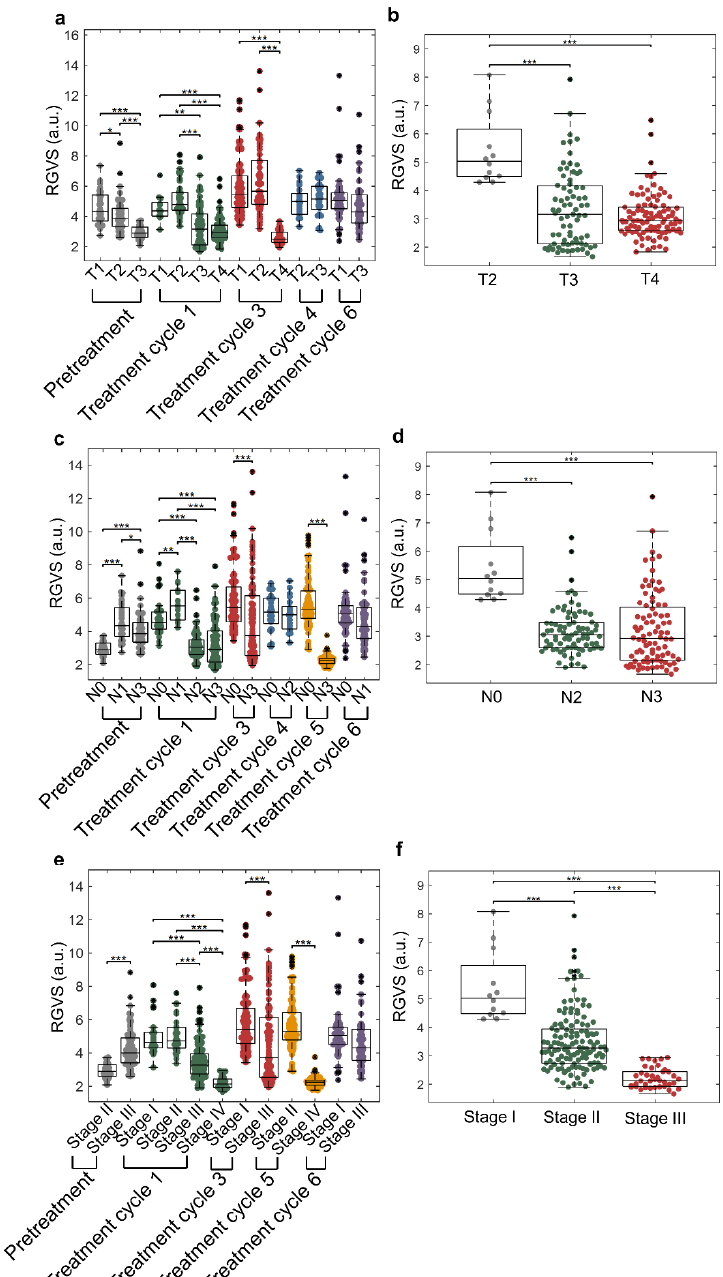
Figure 6. Clinical correlation analysis of patient-derived cell clusters with cancer staging. ( a , b ) Boxplot of the RGVS of patient clusters versus T staging from 19 clinical samples (pretreatment ( n = 3), treatment cycle 1 ( n = 9), treatment cycle 3 ( n = 3), treatment cycle 4 ( n = 2), and treatment cycle 6 ( n = 2)) and gastric cancer samples in treatment cycle 1 (Table 1; no. 6–9, 21–22; n = 6). ( c , d ) Boxplot analysis of patient clusters versus N staging from 21 clincal samples (pretreatment ( n = 3), treatment cycle 1 ( n = 9), treatment cycle 3 ( n = 3), treatment cycle 4 ( n = 2), treatment cycle 5 ( n = 2), and treatment cycle 6 ( n = 2)) and gastric cancer samples in treatment cycle 1 ( n = 6). ( e ) Boxplots of the RGVS of patient clusters versus cancer stages (stage I to stage IV) from 19 clincial samples (pretreatment ( n = 3), treatment cycle 1 ( n = 9), treatment cycle 3 ( n = 3), treatment cycle 5 ( n = 2), and treatment cycle 6 ( n = 2)). ( f ) Boxplots of the RGVS of patient clusters versus cancer stages (stage I and stage III) from gastric cancer patients ( n = 6) in treatment cycle 1, respectively. *** Represents p ≤ 0.001, ** represents p ≤ 0.01, and * represents p ≤